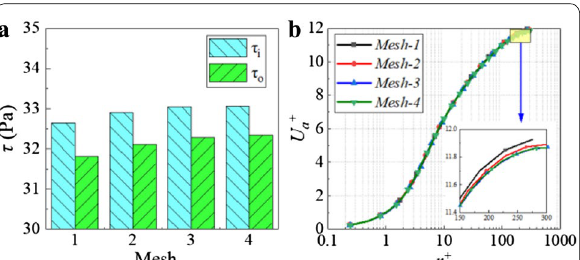
Figure 4 Results of the different meshes: ( a ) Axial shear stresses; ( b ) Axial velocity distributions